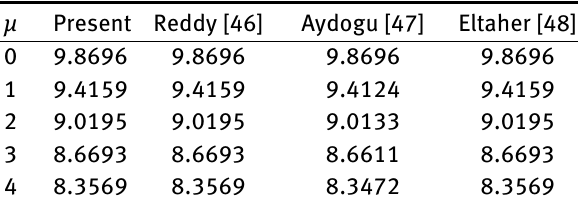
Table 4: Comparisons of first fundamental frequency parameter ( λ ) for SS Nano beam